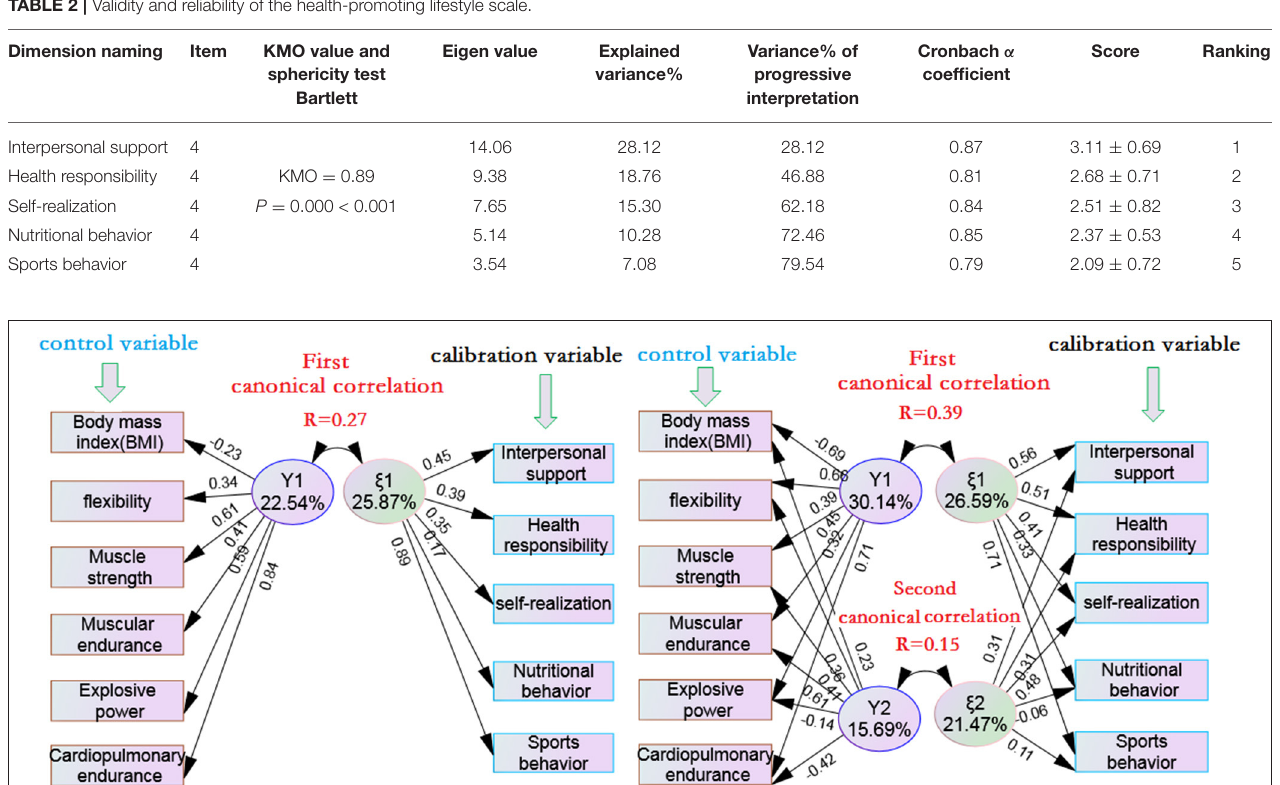
FIGURE 1 | Canonical correlation between health physical fitness and health promoting lifestyle in adolescents of different